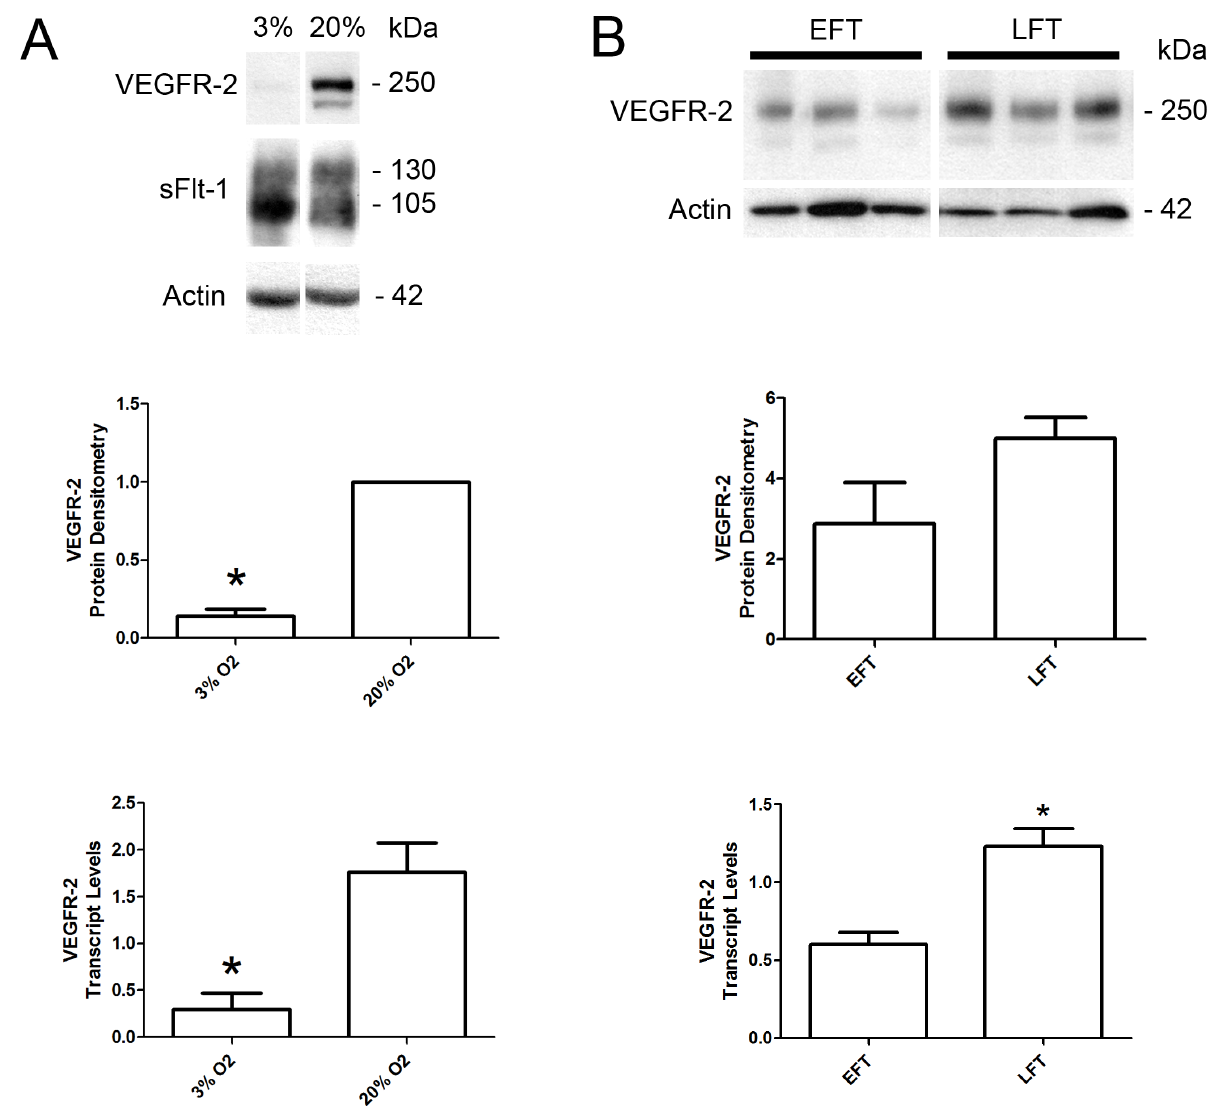
Figure 2. Decreased levels of VEGFR-2 in hypoxia and in early first trimester placentae. A: Representative VEGFR-2 and sFlt-1 immunoblots of placental villous explants cultured at 3% and 20% O 2 . Densitometry analysis comparing normalized VEGFR-2 immunoreactivity between explants cultured at 3% (n=7) and 20% O 2 (n=7). VEGFR-2 transcript levels were assessed by qPCR analysis comparing 3% (n=4) and 20% O 2 (n=4) samples. B: Representative VEGFR-2 immunoblots of early (EFT) and late (LFT) first trimester placentae. Densitometry analysis comparing normalized VEGFR-2 immunoreactivity between samples were not significantly different. Transcript levels were assessed by qPCR analysis comparing VEGFR-2 levels in EFT and LFT placentae. (EFT, n=12; LFT, n=14; * P , 0.05). All values are represented as the means 6 SEM.